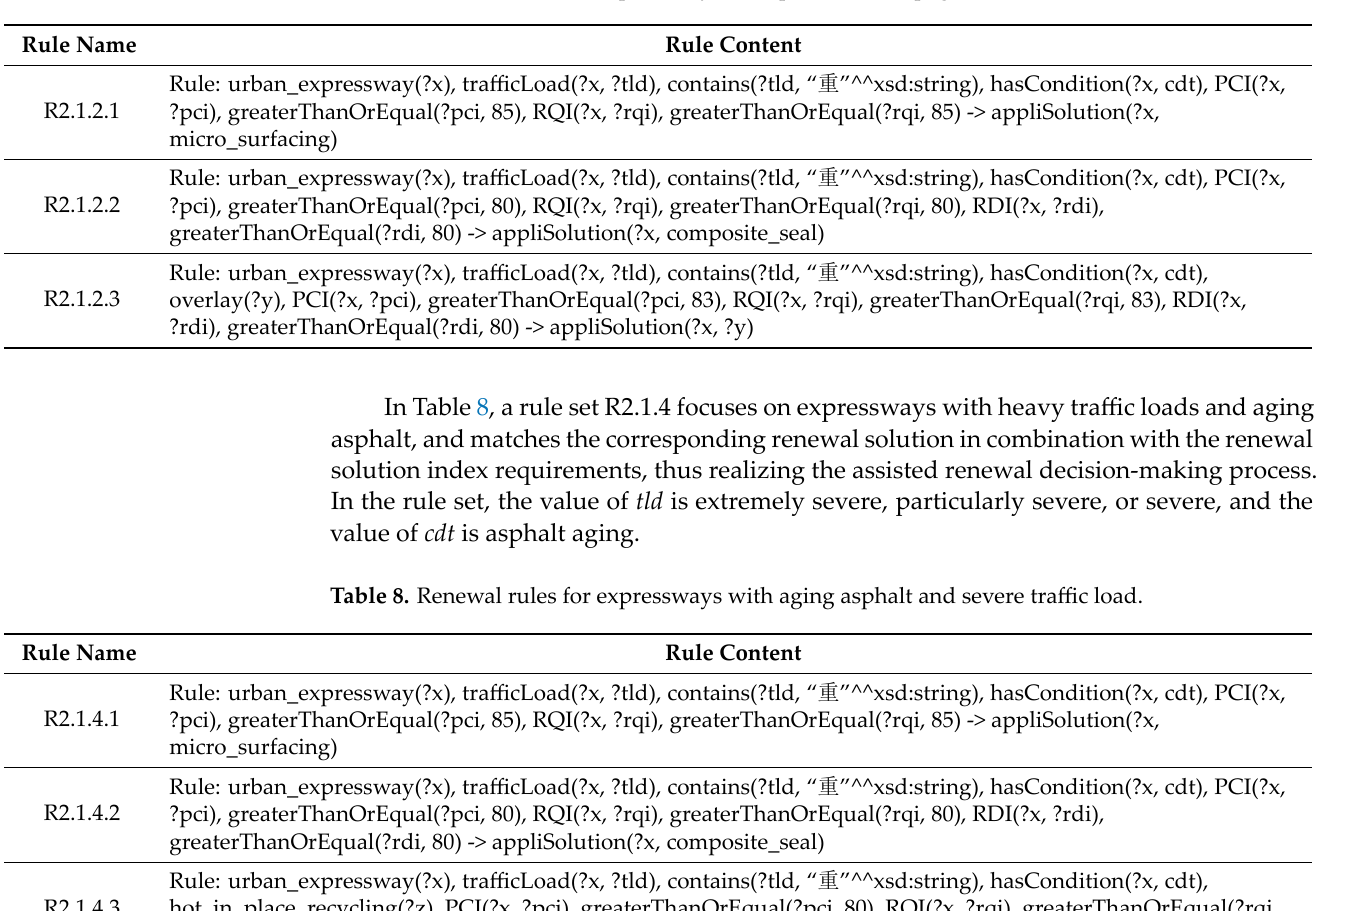
Table 7. Renewal rules for expressways with pavement seepage and severe traffic load.